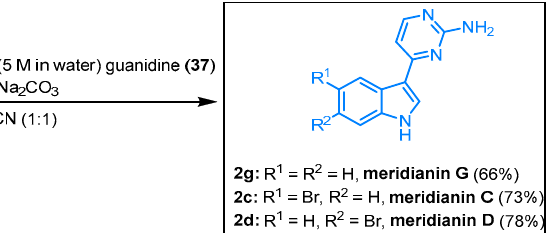
Figure 15. Synthesis of meridianins C, D, and G by Karpov et al. via carbonylative alkynylation [61].